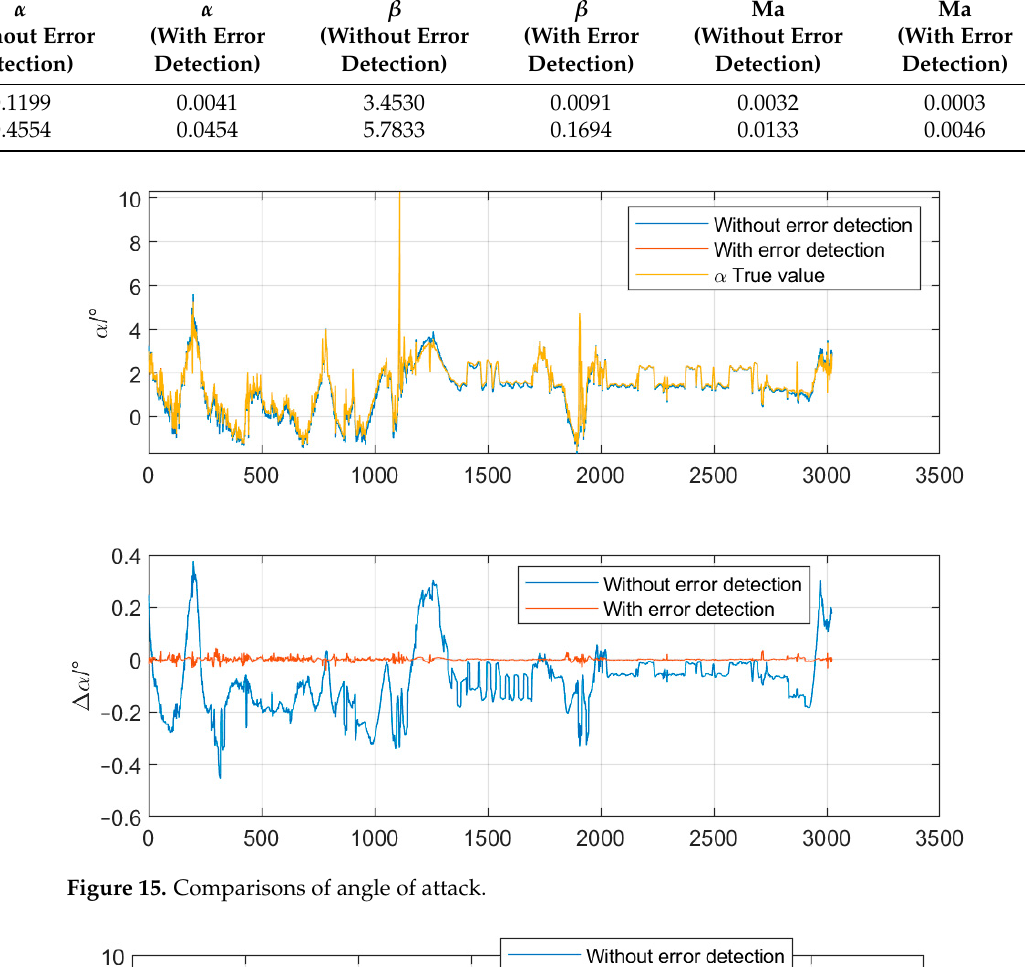
Table 6. Comparisons of the prediction results with and without error detection.